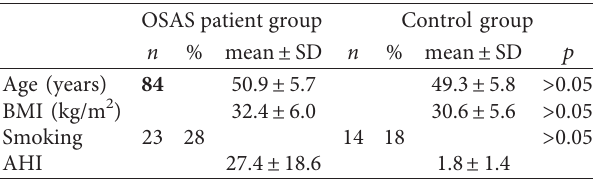
Table 1: Comparison of demographic and polysomnographic characteristics in patients with obstructive sleep apnea syndrome and in the control